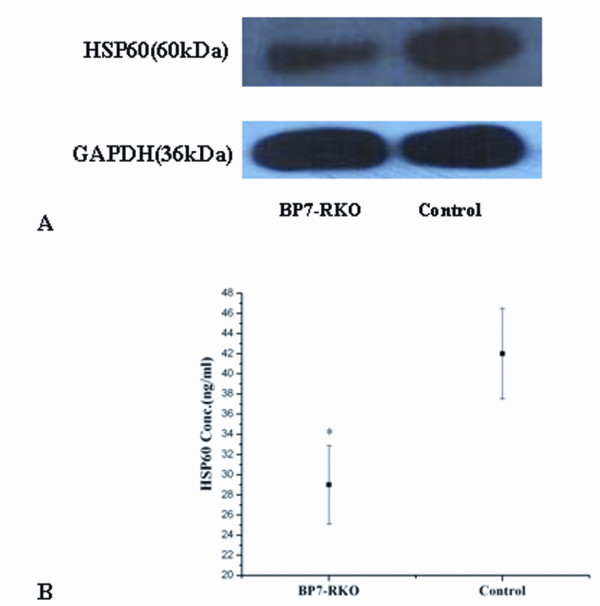
Downregulation of HSP60 protein expression in PcDNA3.1(IGFBP7)-RKO transfectants. A: Whole cell lysates of the stable PcDNA3.1(IGFBP7)-RKO transfectants and PcDNA3.1-RKO transfectants were prepared, and equal amounts of protein (50 μg/lane) were loaded. HSP60 expression was assessed using a rabbit anti-HSP60 antibody. GAPDH is used as an internal loading control. Shown is representive of experiments performed on at least three different isolations. The amount of HSP60 protein expression in PcDNA3.1(IGFBP7)-RKO transfectants was lower than that of the control group. B: HSP60 concentration in cell supernatants was measured using the HSP60 ELISA kit according to the manufactures instructions. Experiments were performed in triplicates. Results represent the mean HSP60 concentration (ng/ml) ± SD,. *, p < 0:05 vs. control.